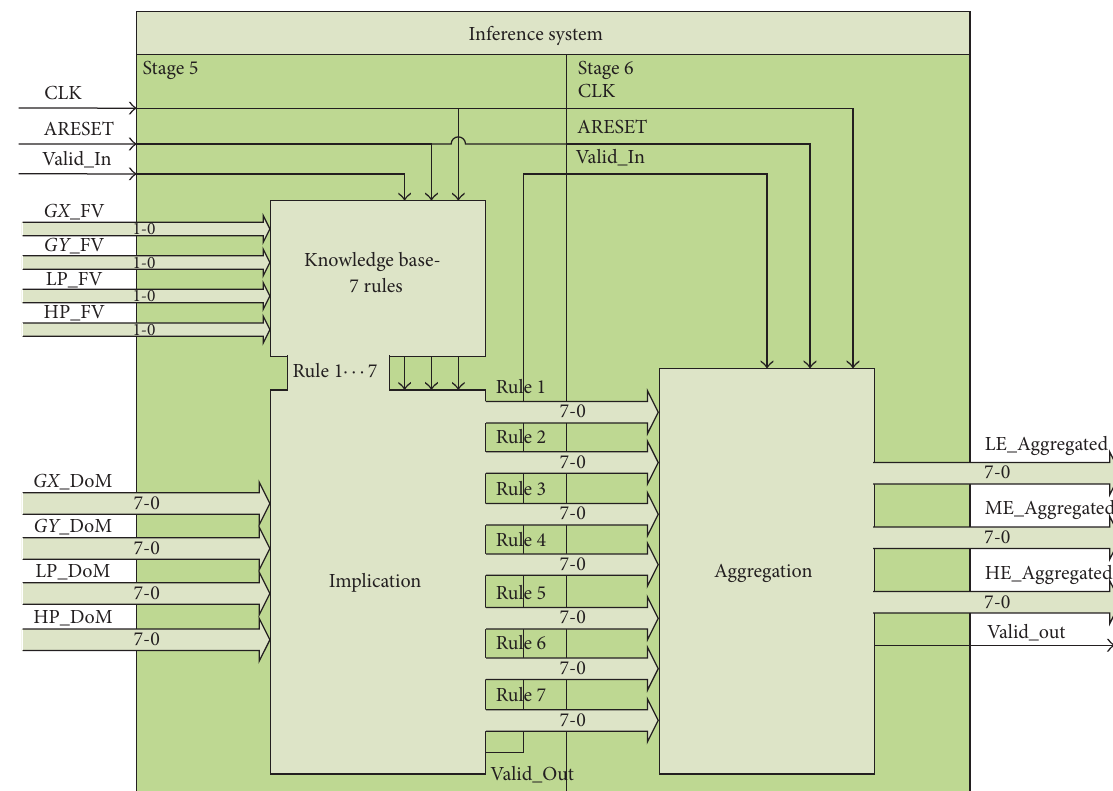
Figure 5: Inference system unit functional block